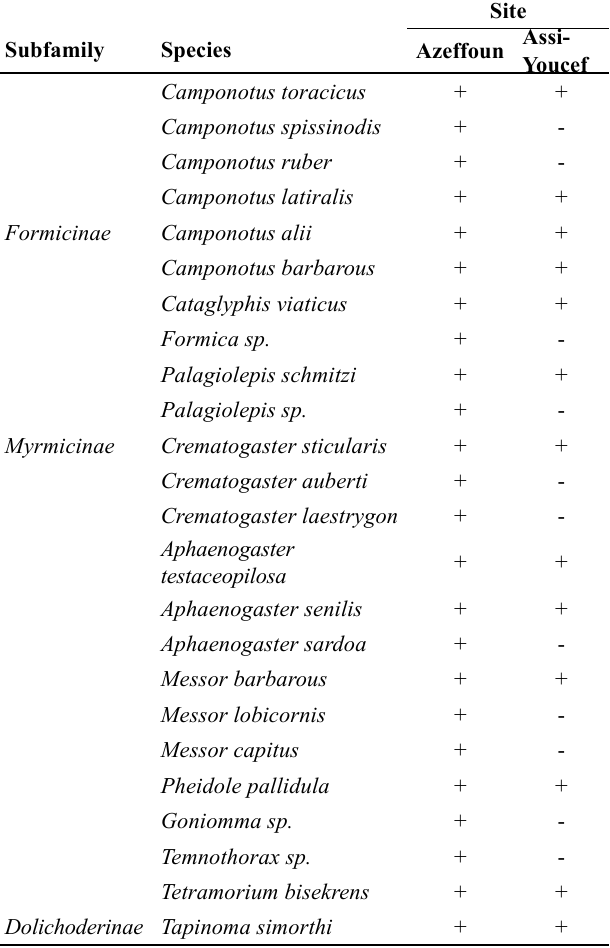
Table 1. Ant species richness in the two study sites.